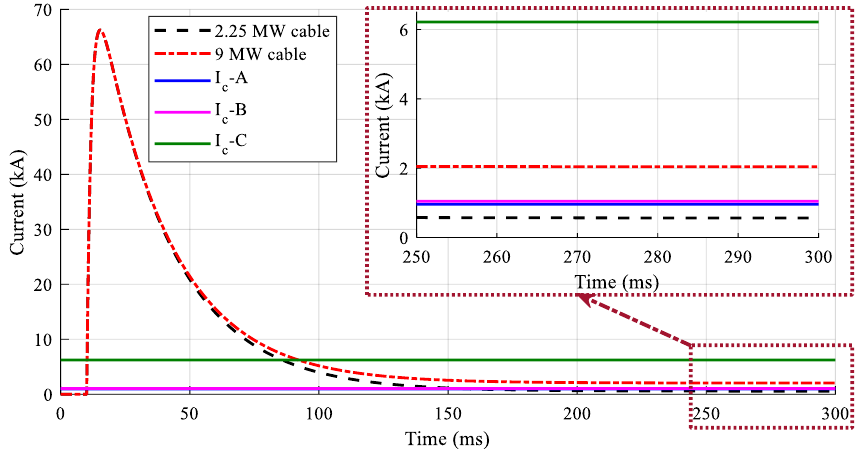
Figure 5 . The fault and operational currents passing through the DC HTS cables . Figure 5. The fault and operational currents passing through the DC HTS